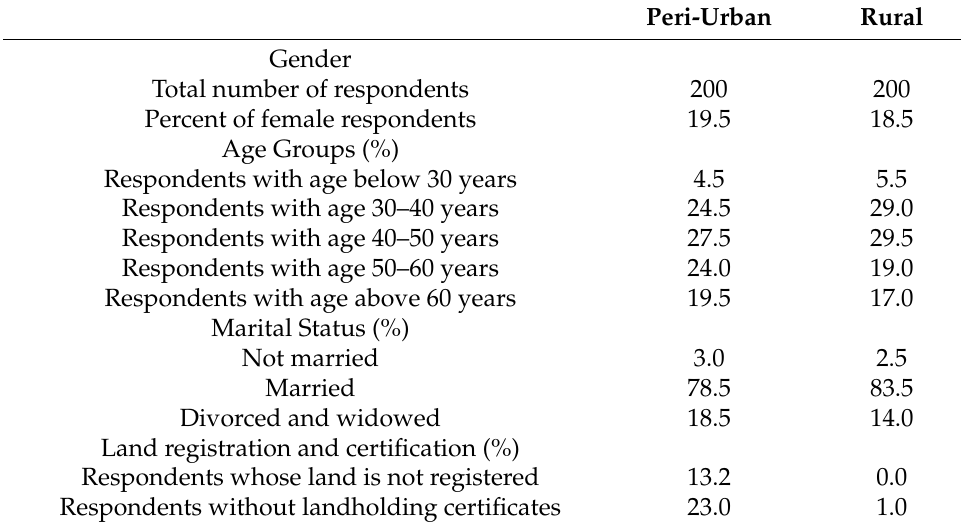
Table 1. Respondents’ characteristics and landholding.